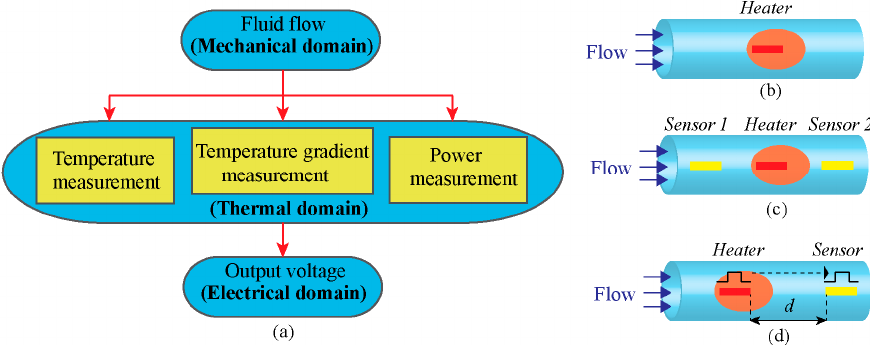
Figure 2. Thermal flow sensor, ( a ) Signal transduction path; ( b ) Hot-wire and hot-film configuration; ( C ) Calorimetric configuration; ( d ) Time of flight configuration.